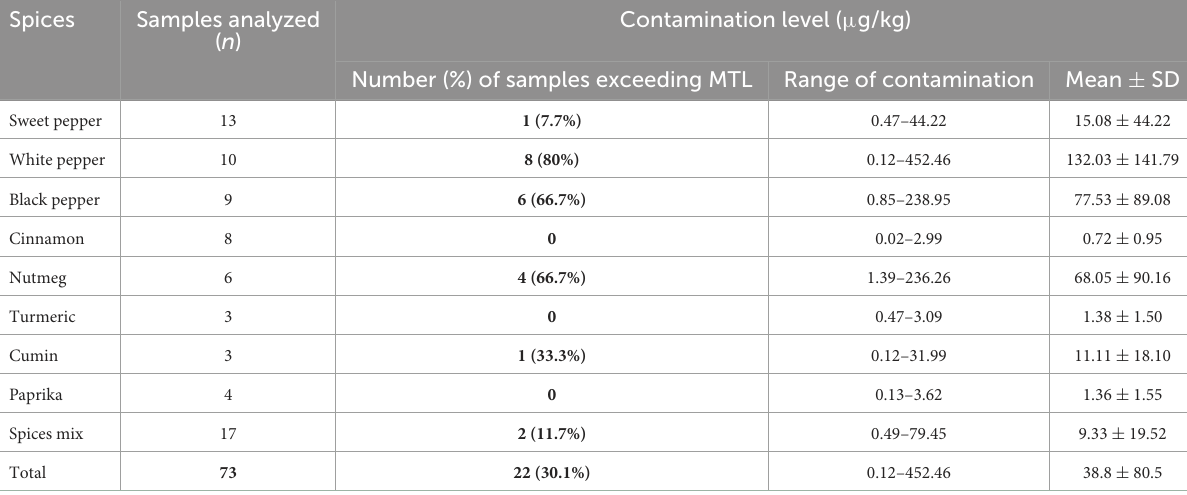
TABLE 2 Incidence and occurrence of OTA in different kinds of spices in